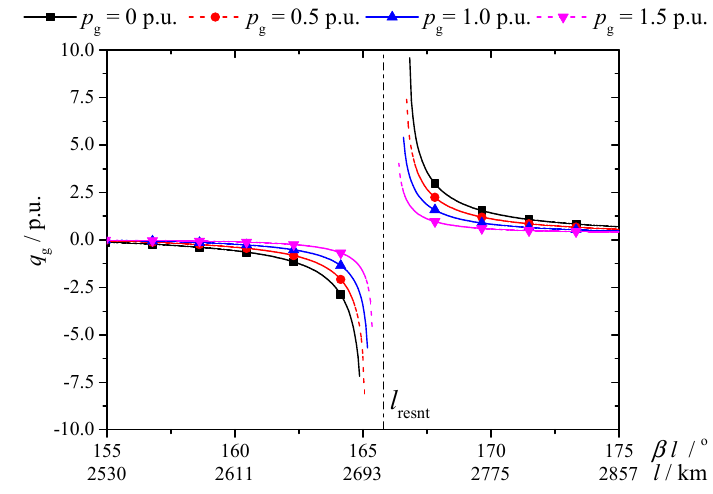
Figure 2. q g of different transmission power and transmission distances.